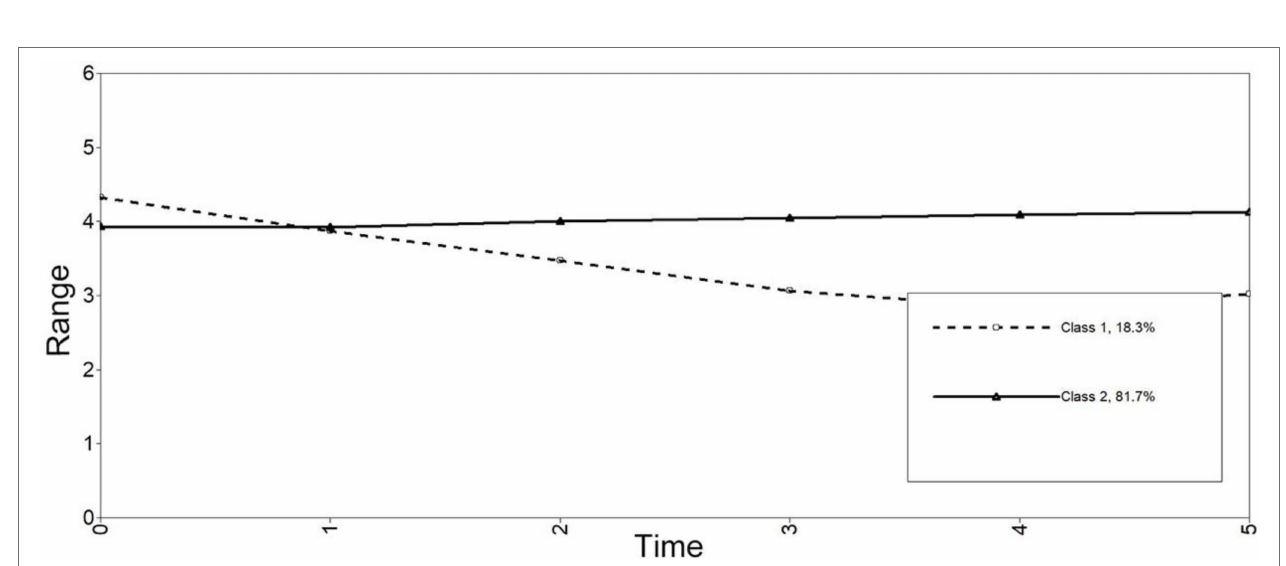
FIGURE 2 | Estimated longitudinal trajectories of enjoyment for